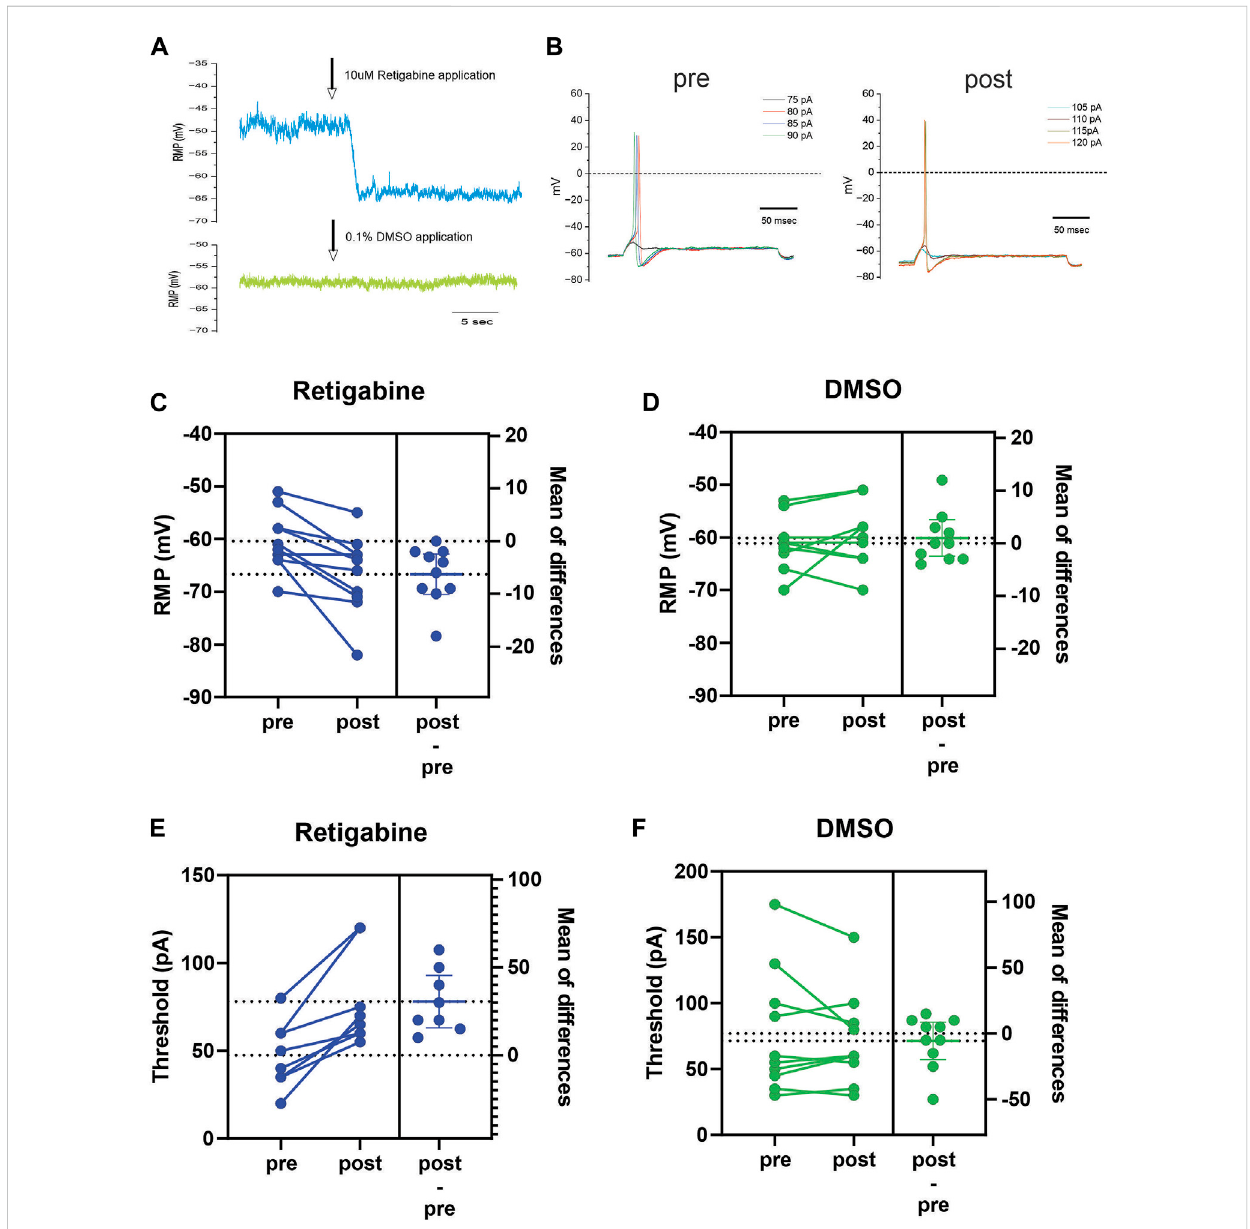
FIGURE 4 Retigabine hyperpolarizes RMP and increases current threshold (A) Example traces showing the hyperpolarizing shift of RMP in response to application of 10 µM retigabine (blue trace). This cell showed a stable RMP of − 49 mV during baseline period and a clear shift of RMP to − 63 mV in response to retigabine. In a different cell, 0.1% DMSO vehicle control caused little or no change of RMP (green trace). (B) Example traces from a representativecellwhich fi rst fi redaspikeat80 pAfromaRMPof − 61 mVduringbaselineperiodandthentheRMPshiftedto − 69 mVinresponseto 10 µM retigabine and increased the threshold to 115 pA. (C) Combined before and after shifts of RMP in response to 10 µM retigabine. Nearly every cell showedahyperpolarizationofRMPandshowedasigni fi cantaveragehyperpolarizationof6.3 mV( n =10). (D) CombinedbeforeandaftershiftsofRMPin response to vehicle control 0.1% DMSO. The shifts were small and variable and the 1 mV depolarizing shift of RMP was not signi fi cant ( n = 10). (E) Combinedbeforeandaftershiftsofthresholdinresponseto10 µMretigabine.Everycellshowedanincreaseofcurrentneededtoelicita fi